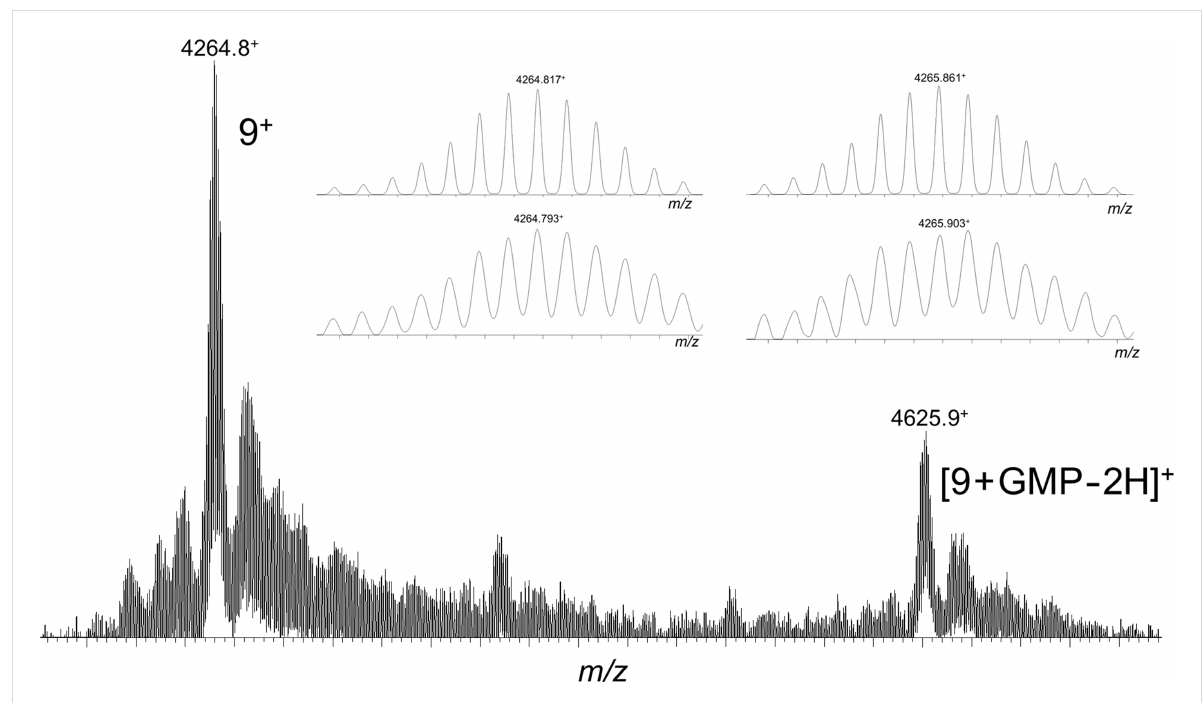
Figure 6: MALDI–MS analysis of a solution containing conjugate 9 and GMP after continuous light irradiation. In the inset, the experimental (bottom) and theoretical (top) isotope distributions are compared for both 9 + and [ 9 + GMP − 2H] + ions.